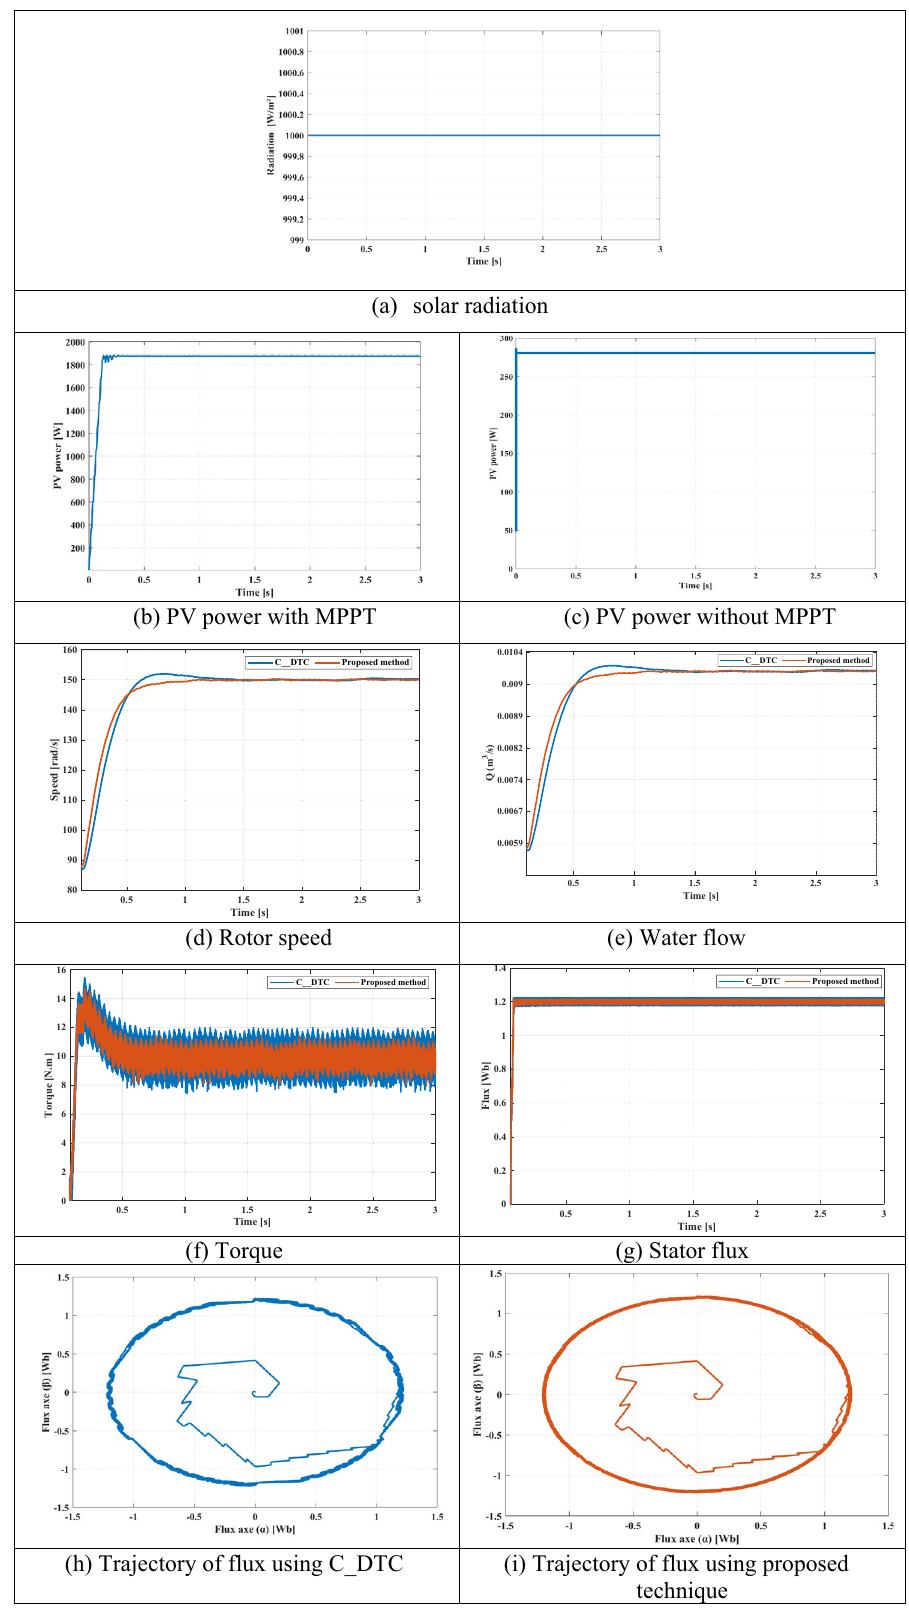
Fig. 10 Performance of PV system under starting